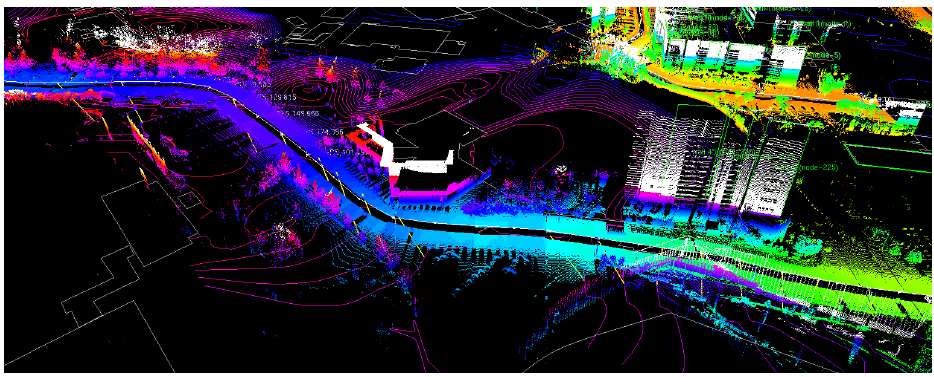
Figure 7. Result of digital map-based SLAM ( a ) Magenta line represents the correspondence of the digital map and building wall (green) extracted by point cloud. ( b ) Loop closure of trajectory generated using wall to wall matching showed by cyan line. ( c ) Correcting in the Z-axis direction, we use matching of Digital Elevation Model (DEM) and SLAM node. the yellow line represents this correspondence. ( d ) We can confirm the z-directional trajectory over the change of color.